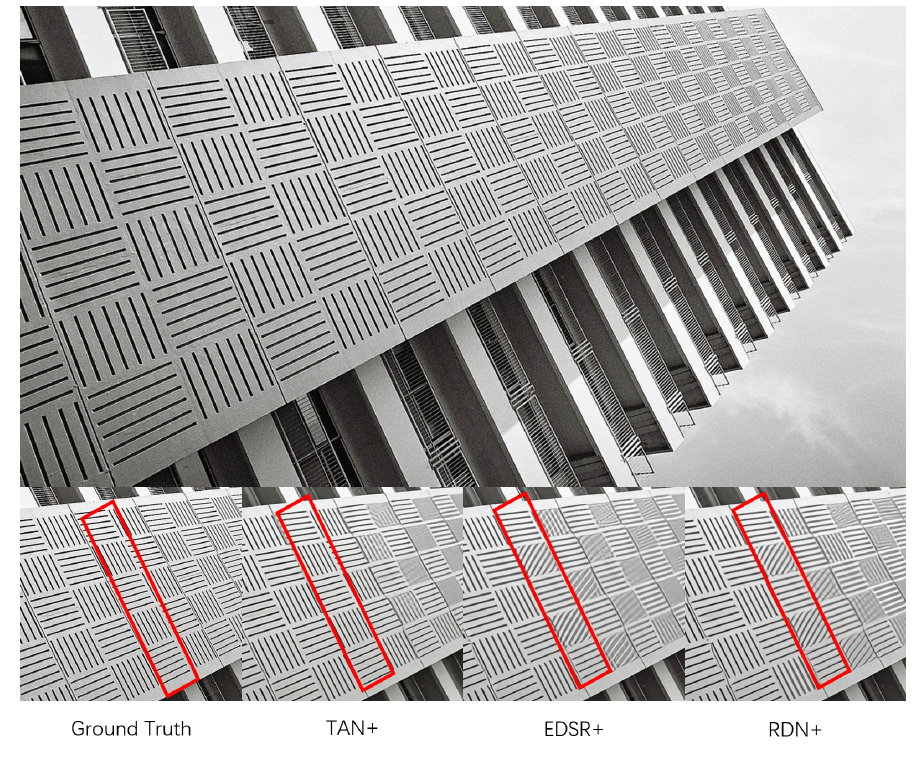
Figure 8. Visual comparison of TAN+, EDSR+, and RDN+.